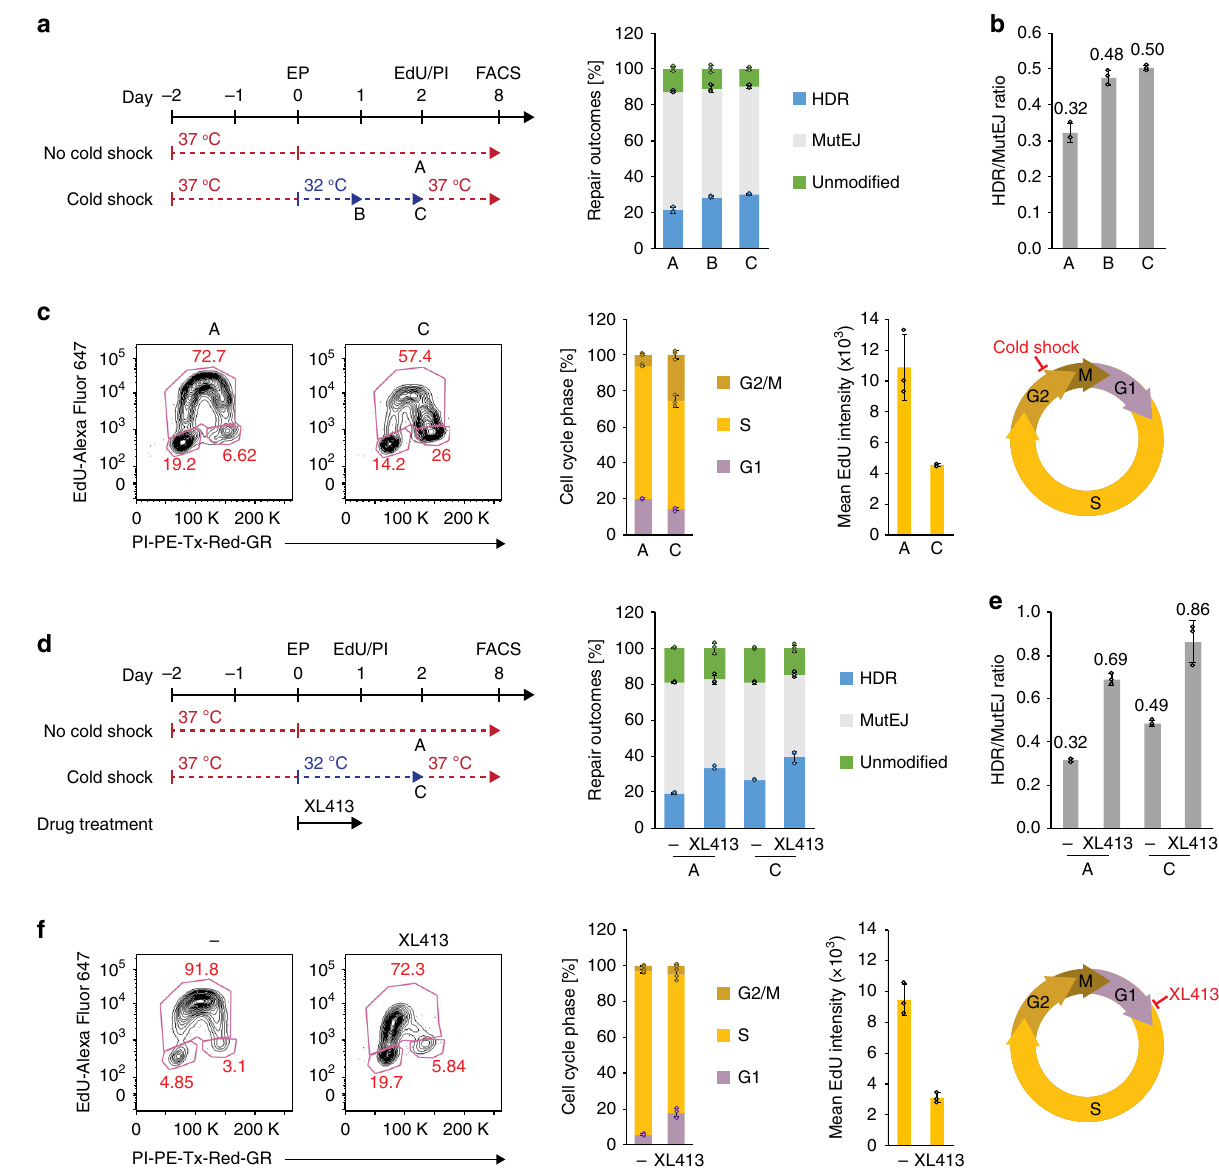
Fig. 2 Cold shock and cell-cycle synchronization with XL413 improve HDR ef fi ciency in iPS cells. a Experimental timeline with no cold shock [A], and cold shock for 24 h [B] or 48 h [C] following electroporation (EP) on day 0 (left). EdU/PI staining was performed after 48 h of culture, and FACS analysis on day 8. The resulting effect on DNA repair outcome frequency is shown (right). b Ratio of HDR/MutEJ repair outcomes measured in a . c Representative FACS plots of EdU/PI staining (left) for quanti fi cation of cell-cycle phase (middle left) and mean EdU intensity of S-phase cells (middle right) 48 h after EP with no cold shock [A] or cold shock for 48 h [C] following EP. Schematic of the cell cycle showing cold shock arrest in G2/M phase (right). d Experimental timeline (left) of XL413-induced cell-cycle arrest for 24 h post-EP, in the absence [A] or presence [C] of cold shock. EdU/PI staining was performed after 24 h of culture, and FACS analysis on day 8. Repair outcomes were quanti fi ed in the absence or presence of XL413 (right). e Ratio of HDR/MutEJ repair outcomes measured in d . f Representative FACS plots of EdU/PI staining (left) 24 h after EP for untreated and XL413-treated cells under normal culture conditions [A], and quanti fi cation of cell-cycle phase (middle left) and mean EdU intensity of S-phase cells (middle right). Schematic of XL413-induced cell- cycle arrest in the G1/early S phase (right). All data are presented as the mean ± S.D. of three technical replicates for each respective treatment. Source data are provided as a Source Data fi